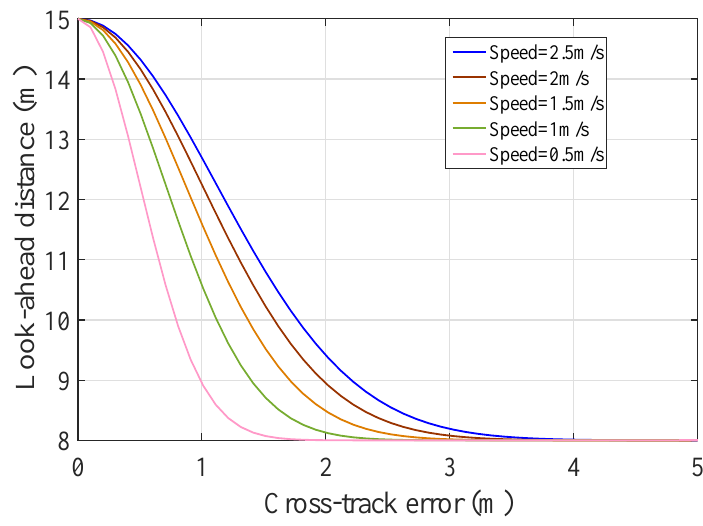
Figure 9. Relationship between look-ahead, cross-track error and speed.